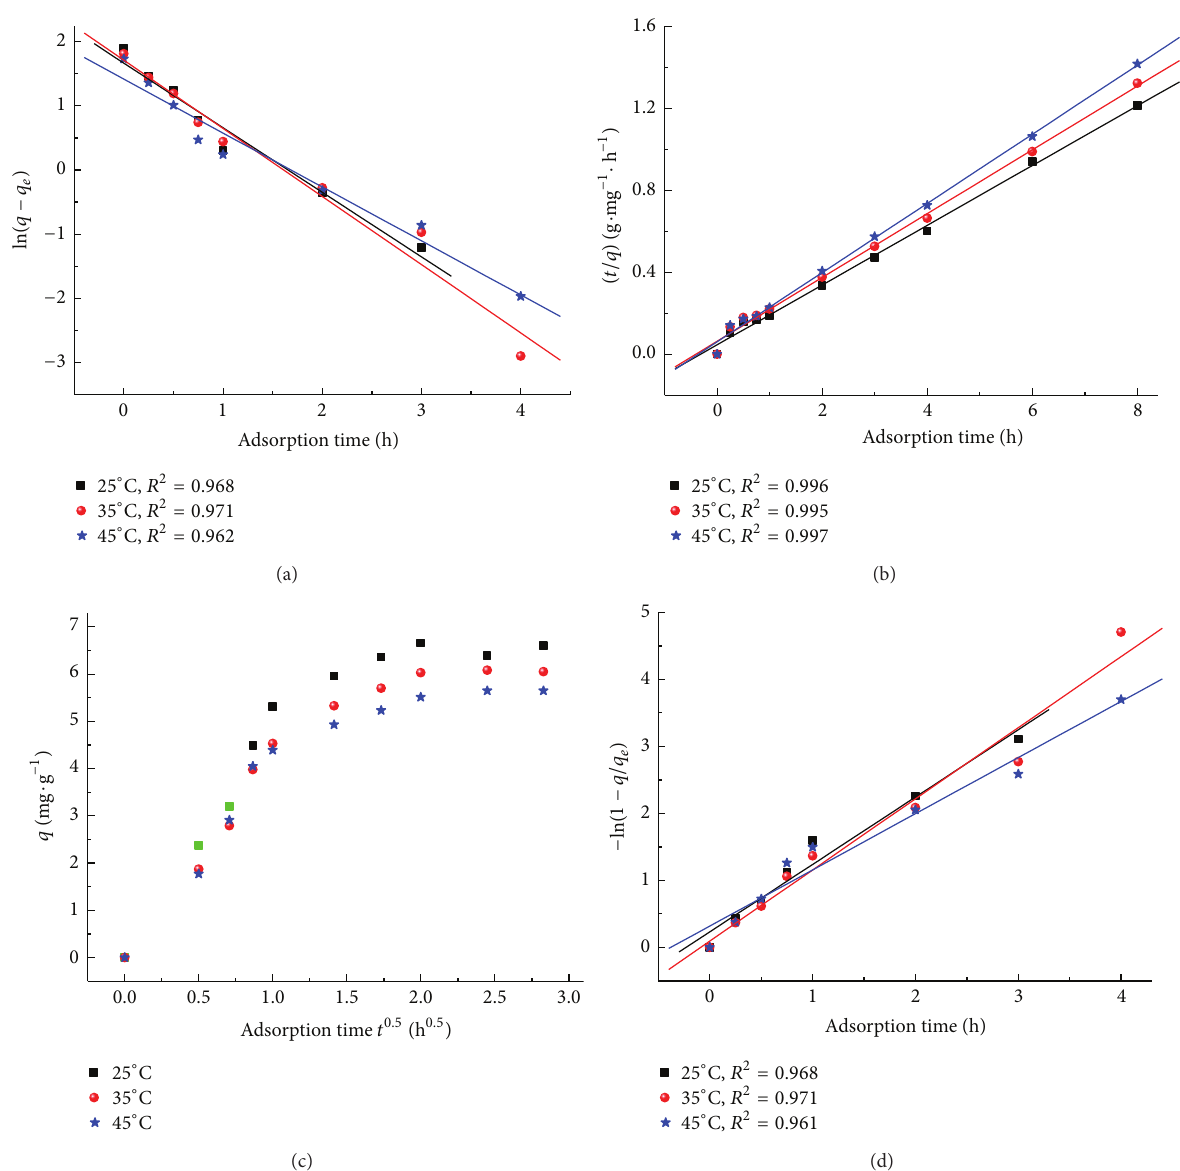
Figure 11: Adsorption kinetics models of activated carbon, (a) Lagergren model, (b) pseudo-second-order model, (c) intraparticle diffusion model, and (d) liquid film diffusion